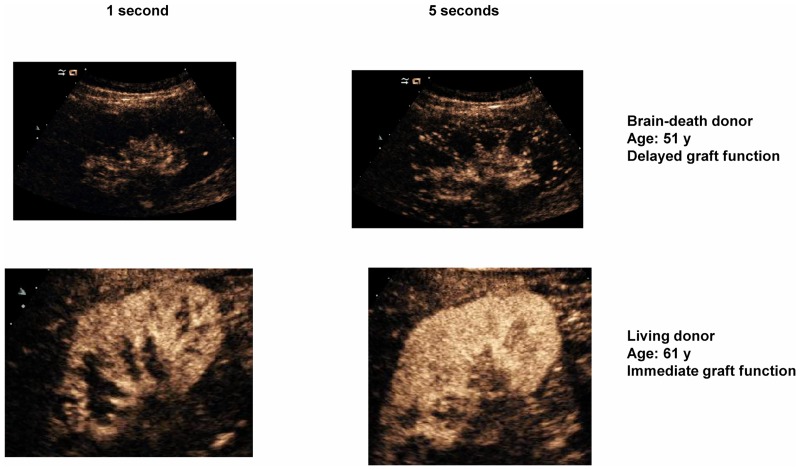
This figure shows the examination performed in the first 48 h of grafting of two representative patients.The first was a brain-death donor with acute tubular necrosis and the second was a living donor. We observed the obvious differences between patients: Graft microcirculation from living donor was quicker and more intensive that graft microcirculation from brain-death donor.